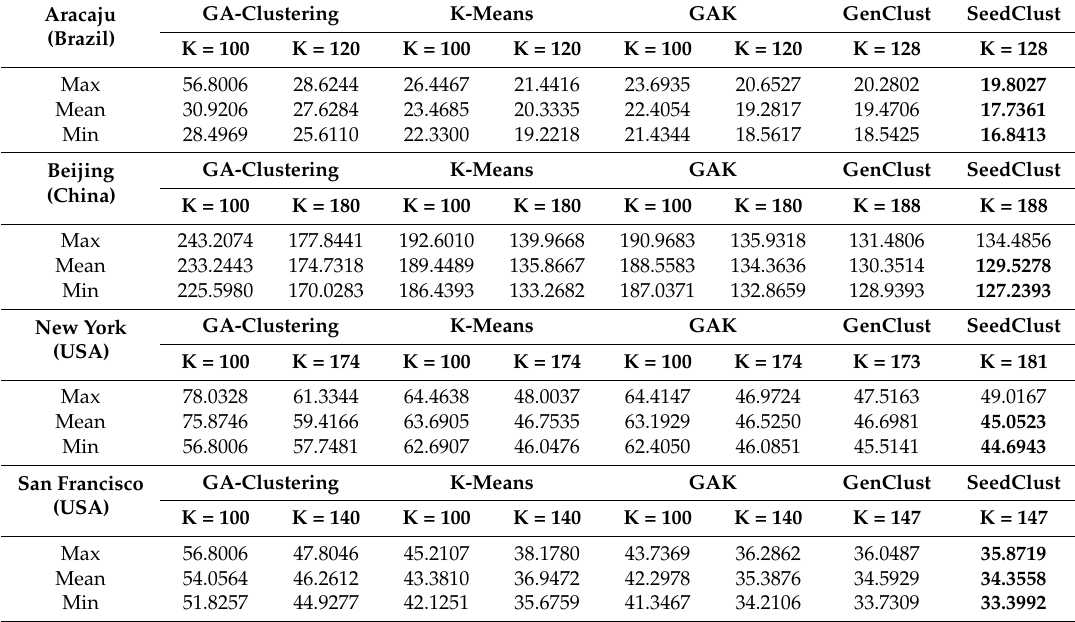
The bold font indicates the best value for each taxi GPS data